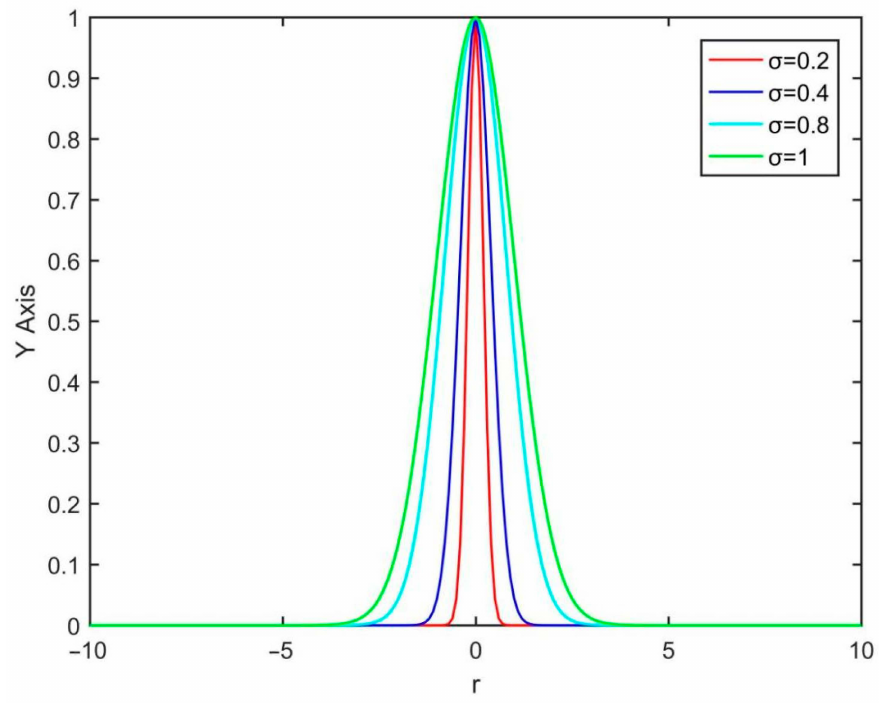
Figure 4. Gaussian radial basis